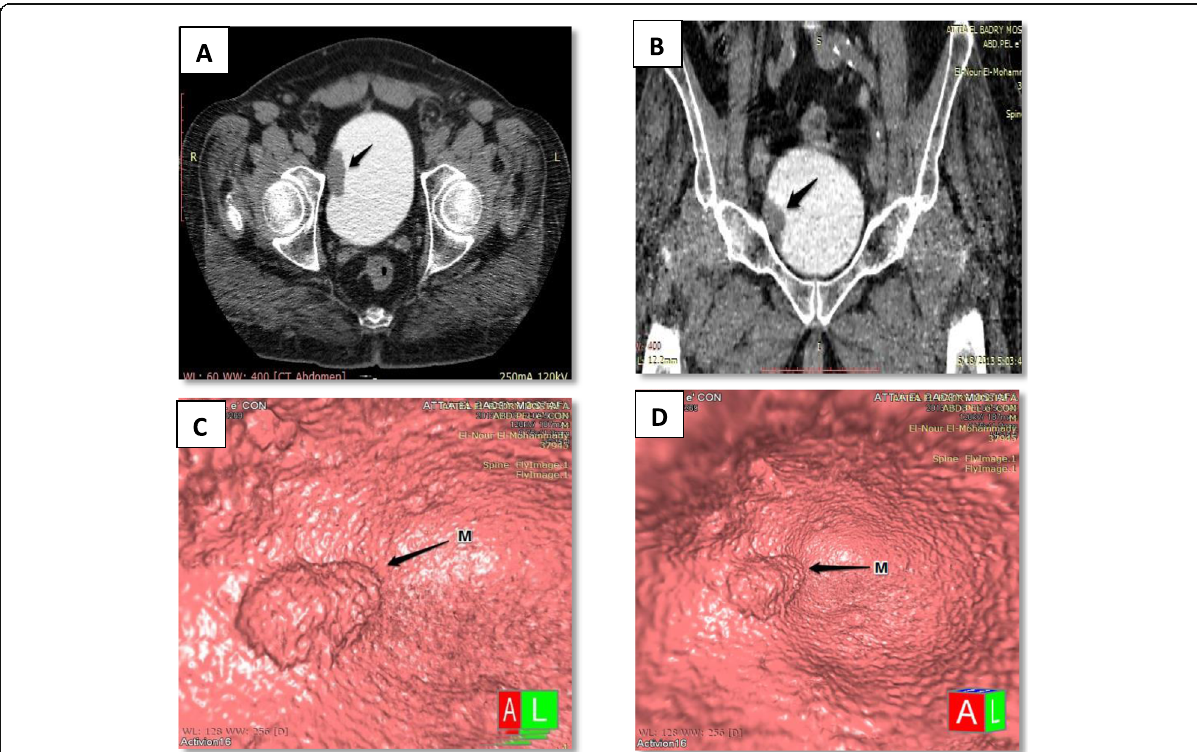
Fig. 2 a , b Male patient 51 years old presented with gross hematuria. Axia ( a ) and coronal ( b ) contrast-enhanced CT images showed right urinary bladder wall soft tissue mass (about 3 × 2 cm) with irregular lateral wall contour denoting infiltration of the muscle layer; however, the right lateral paravesical fat and lateral pelvic bony as well as muscular walls are preserved, with no sizable lymphadenopathy nor distant metastases. c , d Virtual cystoscopy images confirmed the lesion showing its clear morphology (arrowed). Conventional cystoscopy was done and revealed the right lateral wall mass with no other lesions could be detected. Biopsy was taken and revealed invasive transitional cell